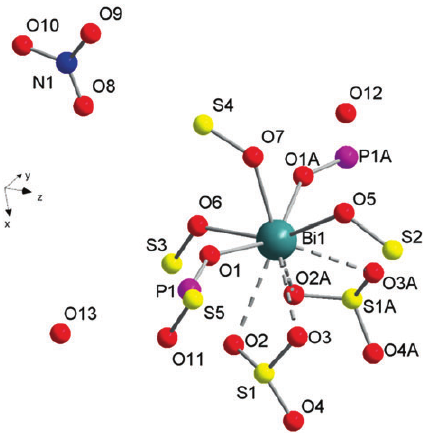
Table 1 Selected interatomic distances ( Å ) and angles (degrees) in H P(O)SO ) (DMSO) ] 18 14 3 2 3 occupation factor of